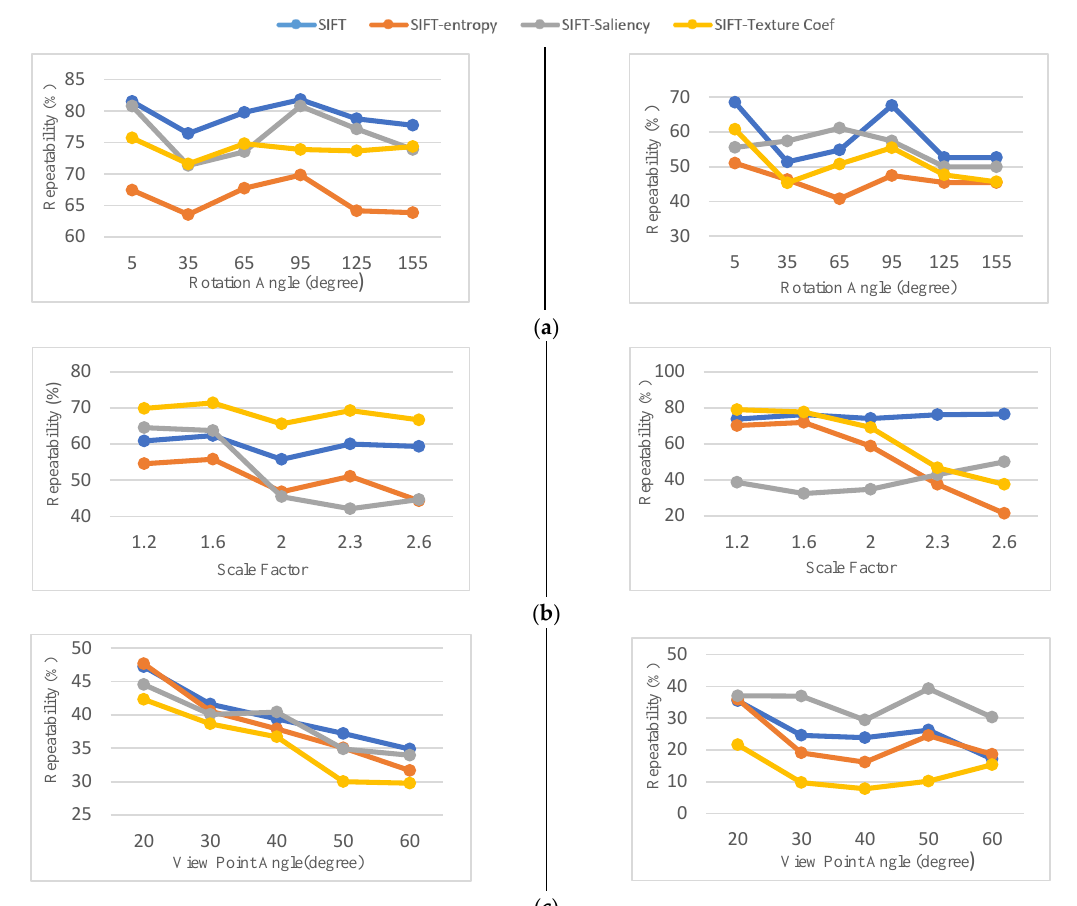
Figure 7. Repeatability results for the synthetic image pair of S1 (left column) and S2 (right column). ( a ) Rotation, ( b ) scale, ( c ) viewpoint change.